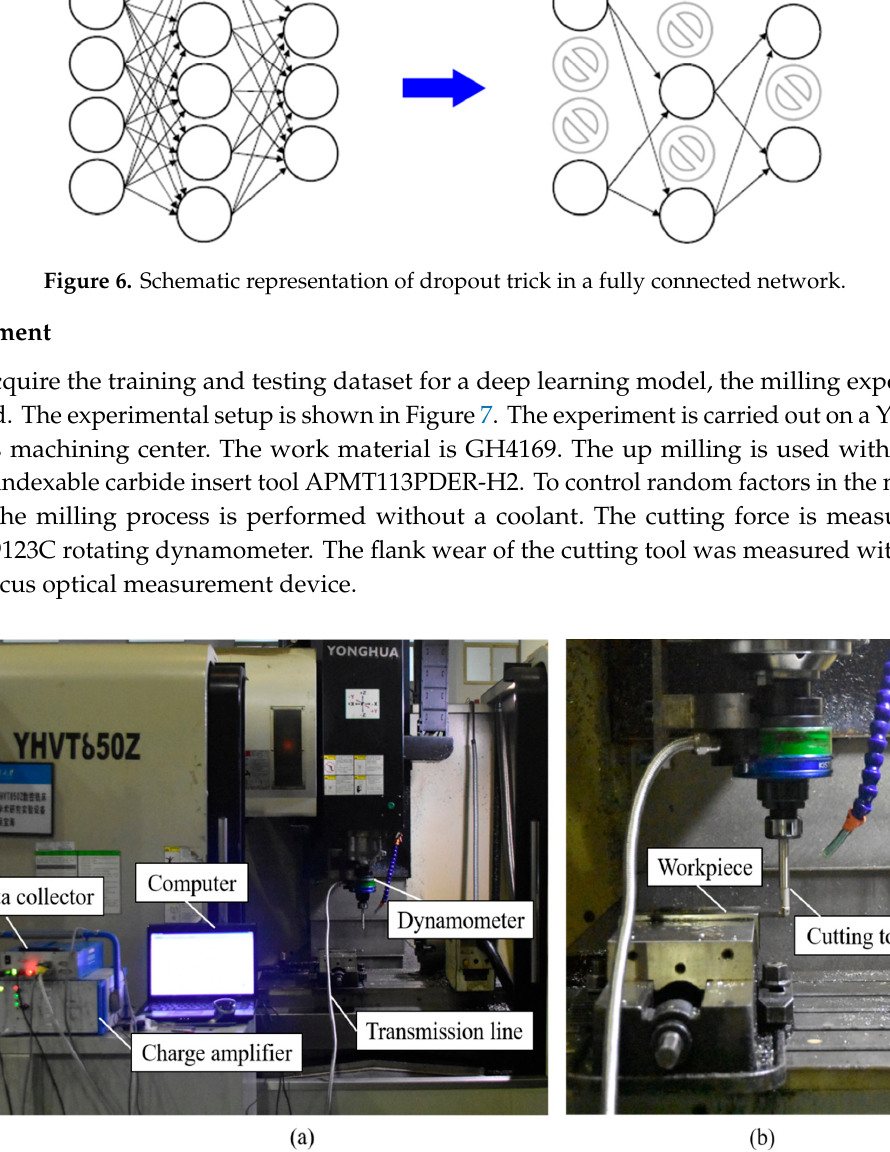
Figure 7. Experimental setup: ( a ) cutting force online measurement system, ( b ) layout of cutting tool and workpiece.